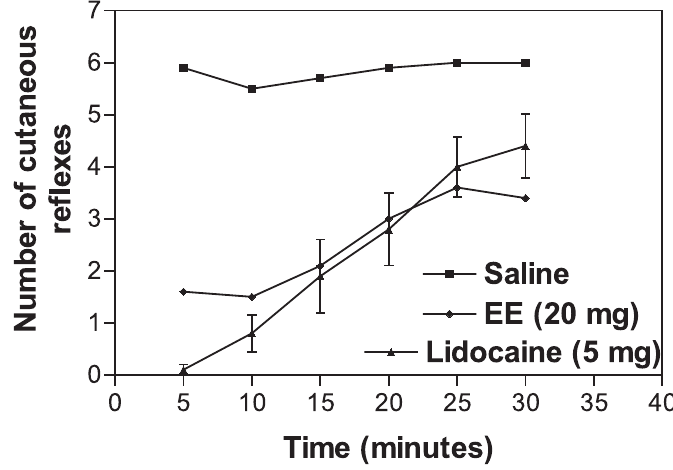
Figure 3 - Infiltration anesthesia in guinea pig wheal test. Effect of the ethanolic extract (EE) of Ottonia martiana (20 mg, n=10) on cutaneous reflexes in guinea pig wheal test. Inhibition was statistically significant compared to saline control (p < 0.05), but similar to lidocaine (2